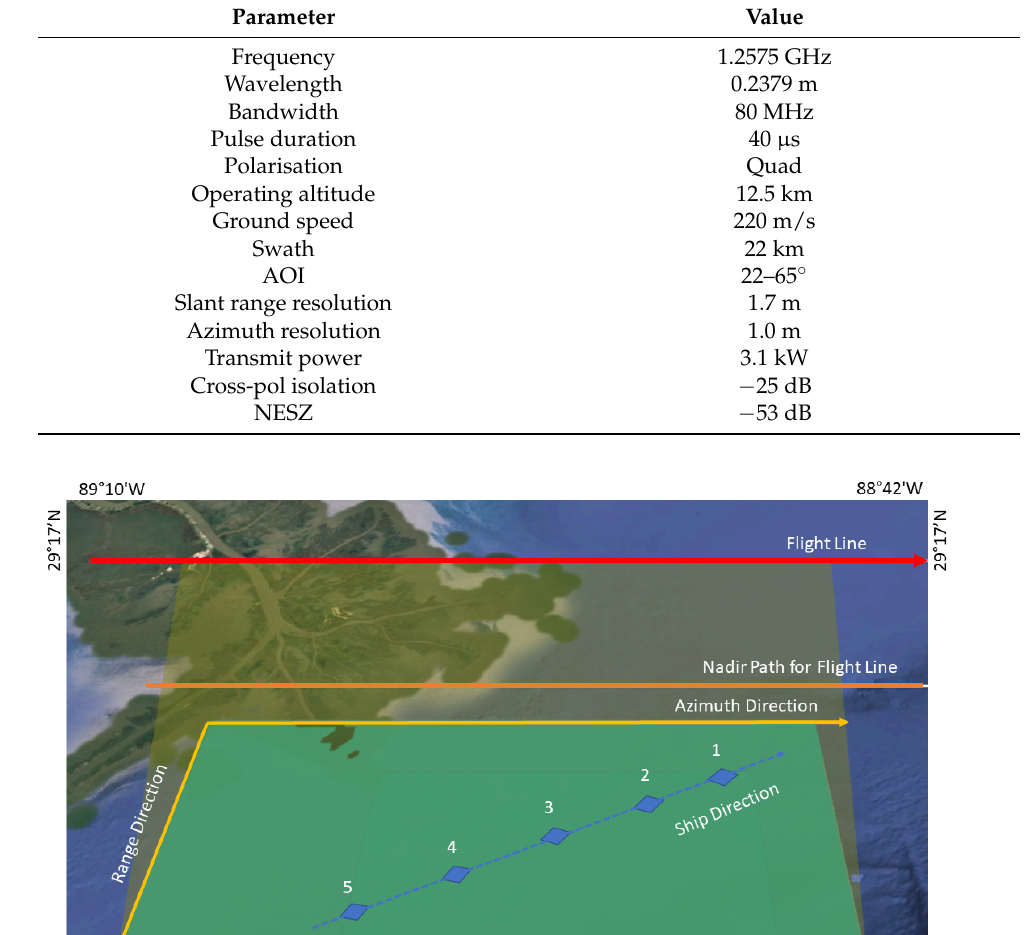
Table 1. UAVSAR operating parameters.